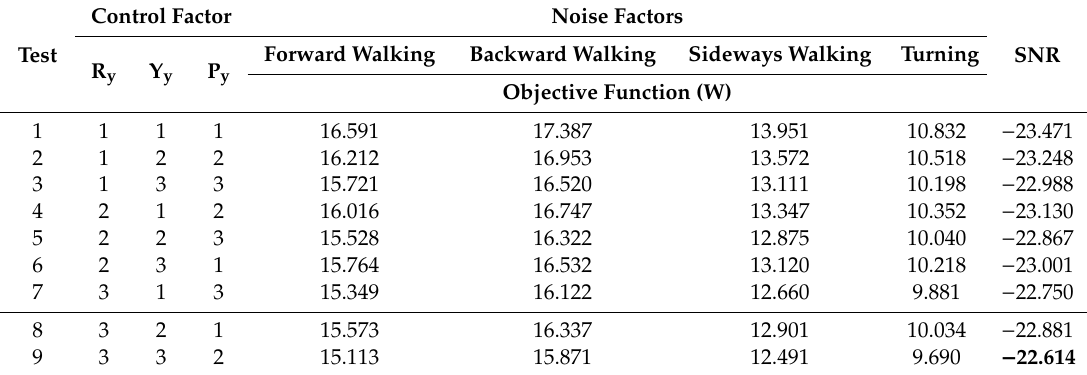
Table 4. Design, results, and SNRs of the second experimental set. (The highest SNR is boldfaced.)